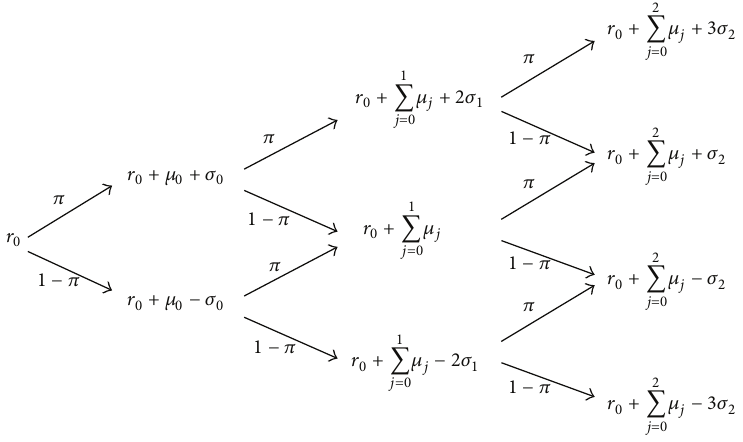
Figure 2: 4-period time-varying interest rate tree.